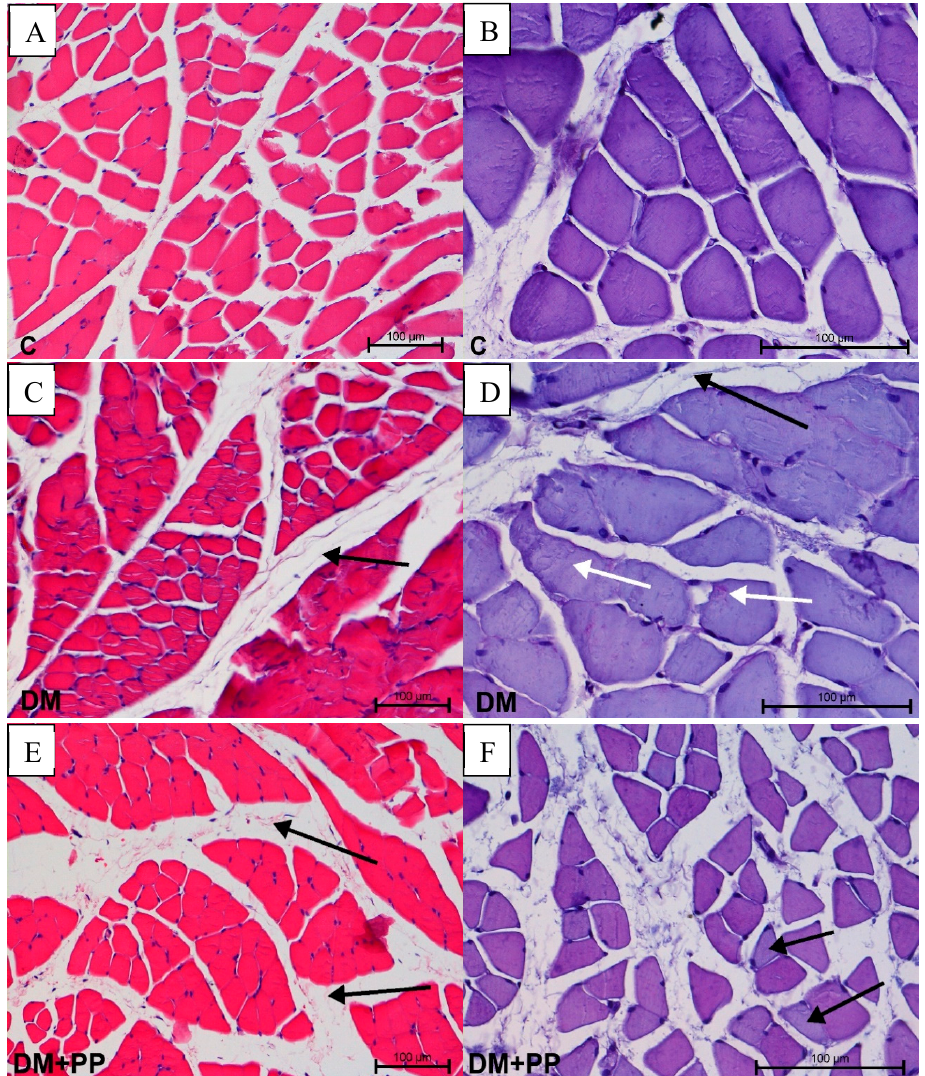
Figure 6. Histopathological studies of Blue Congo extract on the muscle tissue of streptozotocin (STZ)-induced diabetic rats. Note the presence of edema of connective tissue in the DM and DM + PP groups (arrow); photos on from the left side ( C , E ). Different periodic acid–Schiff (PAS)-positive reaction (white arrows) in myocytes ( D , F ). Photos on left side stained with hematoxylin and eosin (H&E), magnification 200× ( A , C , E ); photos on right side show PAS-positive staining, magnification 400× ( B , D , F ). C—control rats (healthy rats), DM—diabetic rats, DM + PP—diabetic rats treated with Blue Congo extract for 14 days (at a dose of 165 mg / kg b.w. /